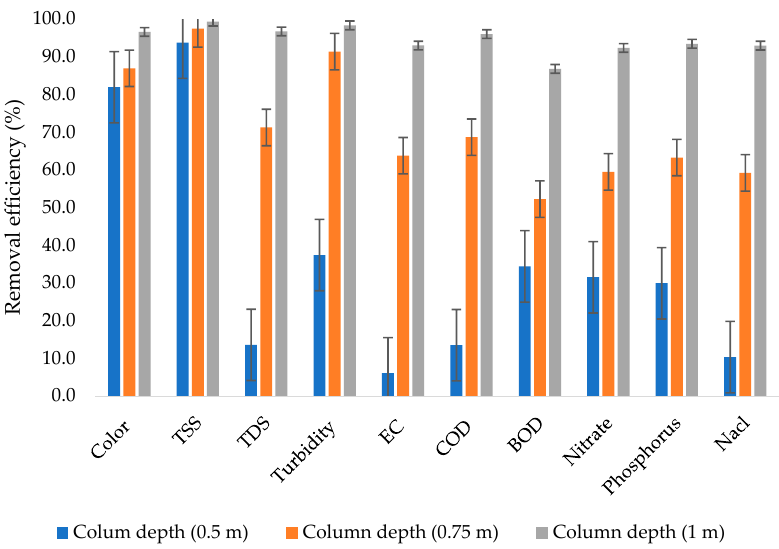
Figure 3. Removal efficiencies from different column depths.